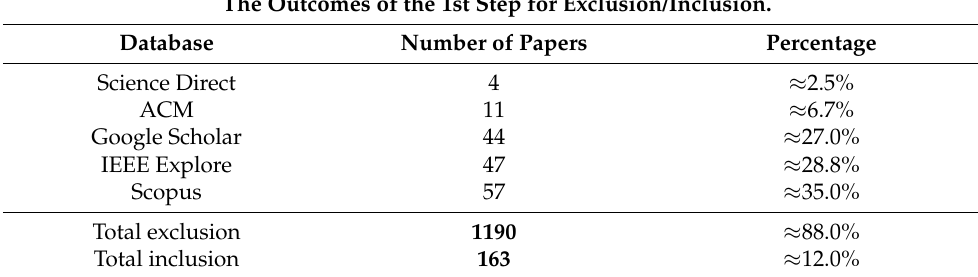
Table 6. The outcomes of the 1st step for exclusion/inclusion. The Outcomes of the 1st Step for Exclusion/Inclusion.